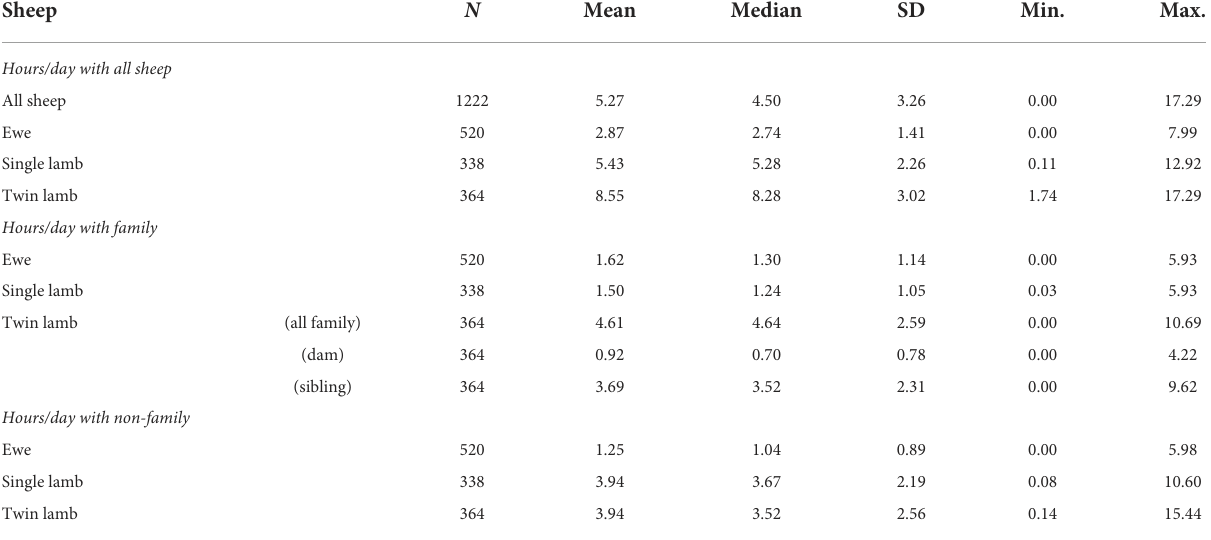
TABLE 3 Descriptive statistics of hours/day over 13 days that sheep spent with other sheep: overall, within family and out of family for ewes, single and twin lambs. Sheep N Mean Median SD Min. Max. Hours/day with all sheep